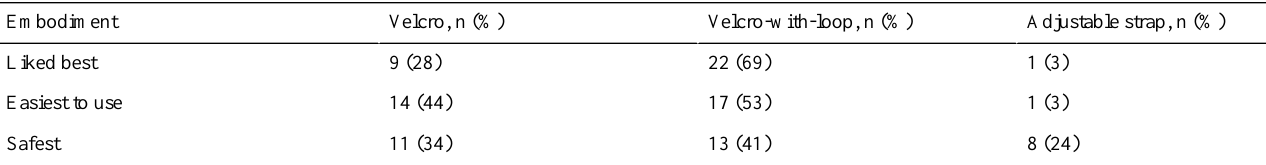
Table 4. Subjects' perceptions of different band embodiments (n=32). All values are given as n (%).